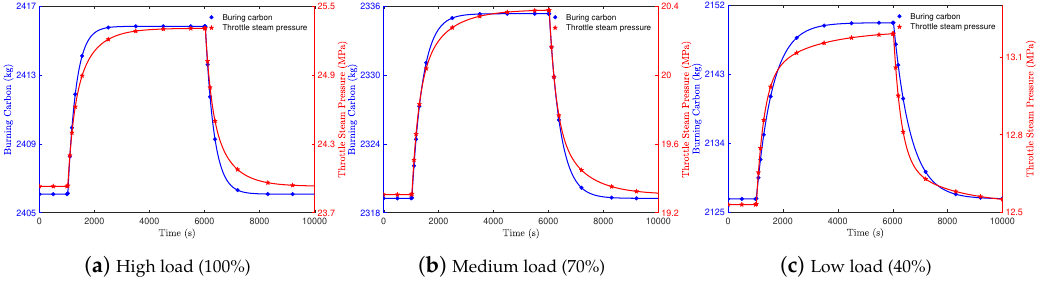
Figure 3. Performance of burning carbon in a supercritical CFB unit when u B increases by 5% at 1000 s and decreases by 5% at 6000